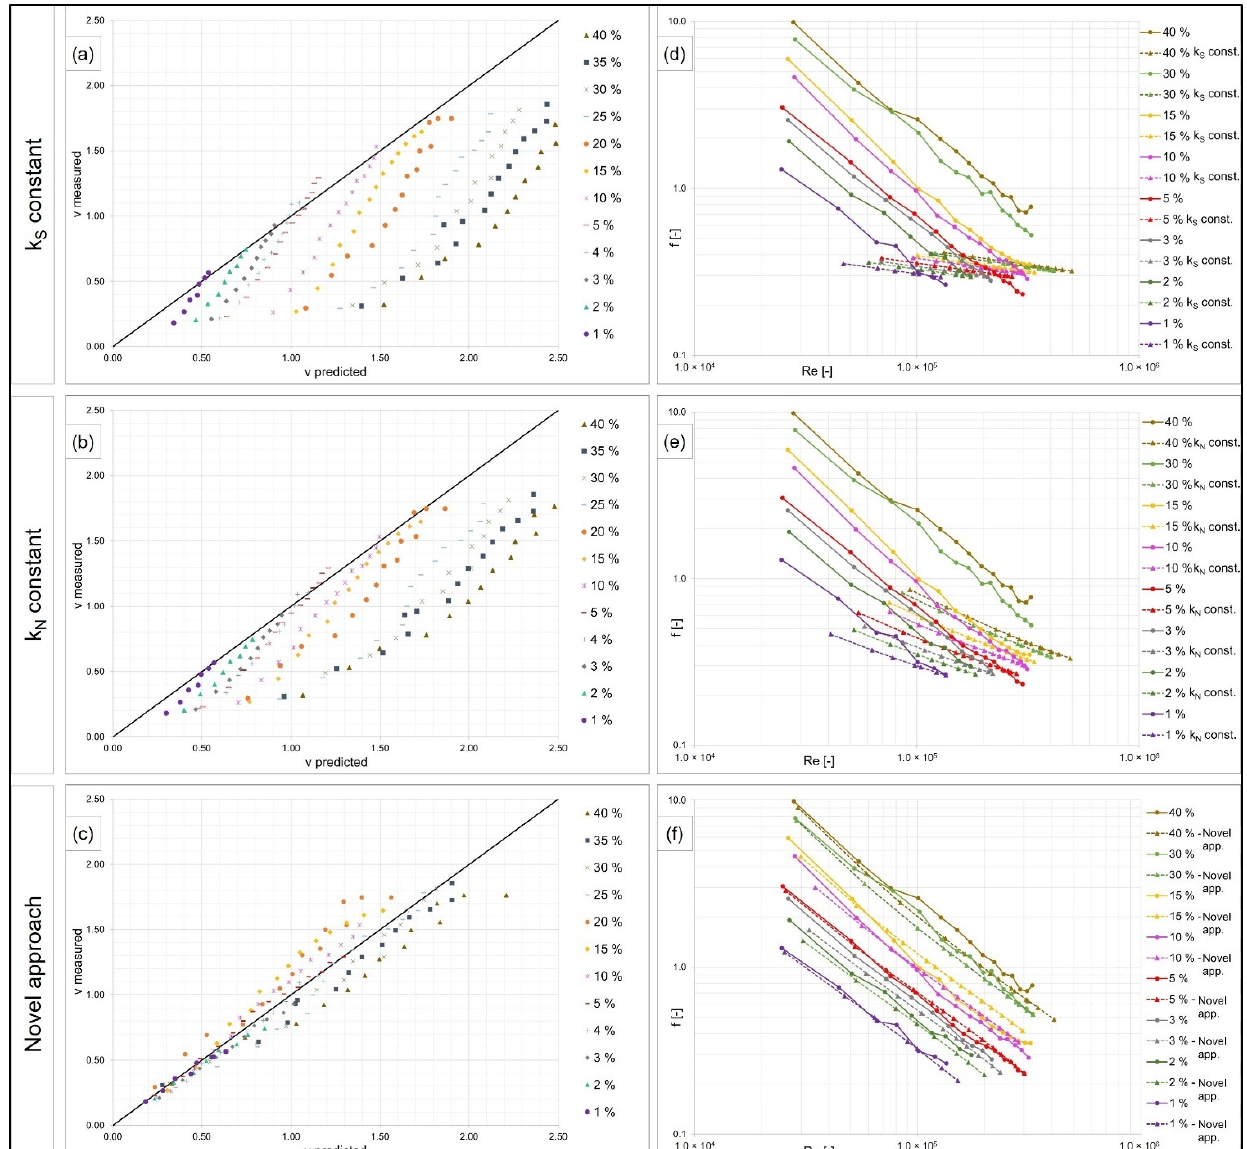
Figure 6. Comparison of approaches k S = constant, k N = constant and novel approach for quality assurance. ( a – c ): Comparison of predicted velocity and measured velocity. ( d – f ): Comparison of Reynolds number Re and friction factor f (logarithmic) for measurements (continuous lines) and predictions (dashed lines).